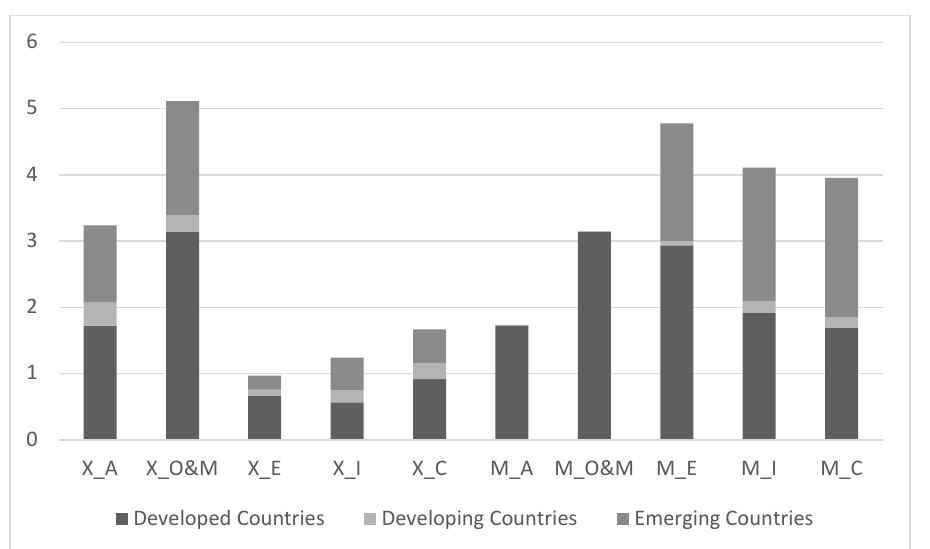
Figure 4 : Latin America: exports and imports by products and group of trading partners (% of GDP),average